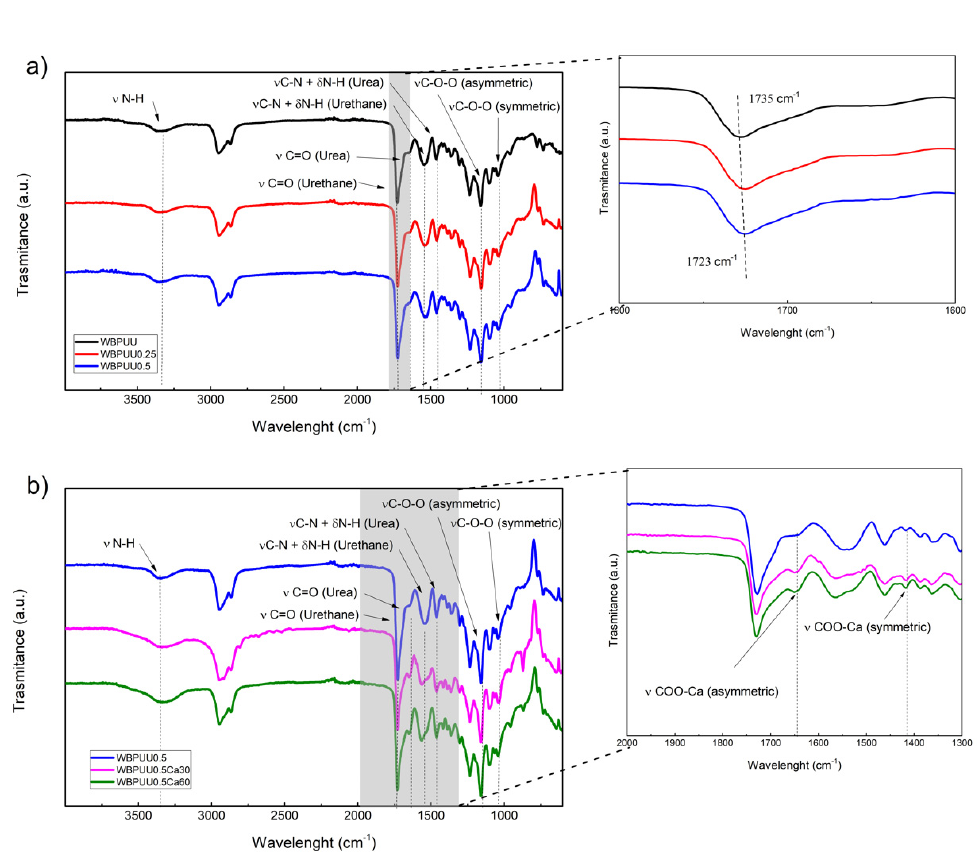
Figure 7. Spectra of the prepared scaffolds: ( a ) WBPUU scaffolds with different CNC content, and enlargement of the 2000–1400 cm − 1 interval of ( a ) (inset), and ( b ) WBPUU/CNC scaffolds with different immersion times in CaCl 2 , and enlargement of the 2000–1300 cm − 1 interval of ( b ) (inset). Table 3. Assignments of FTIR bands for WBPUU and WBPUU crosslinked with Ca 2+.